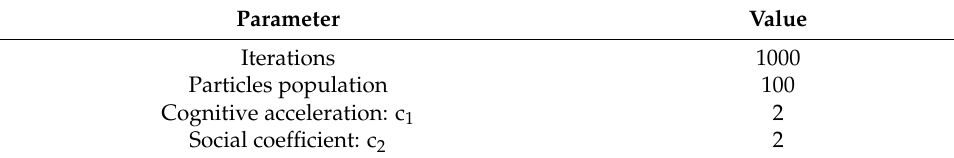
Table 4. PSO parameters.